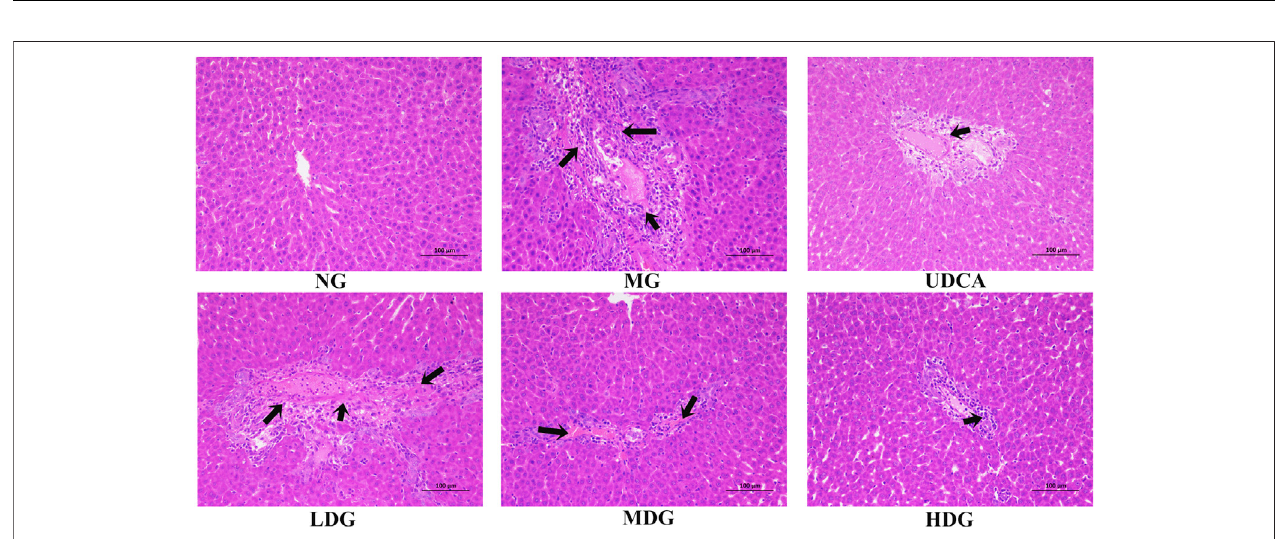
FIGURE 3 | Representative histopathological section photos of liver specimens of rat with H&E staining (200 × magni fi cation). Damage to hepatocytes is pointed by black arrows.